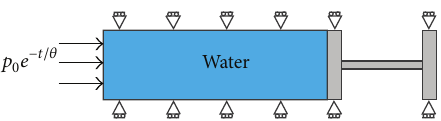
Figure 9: A sketch of the boundary conditions in the analysis of